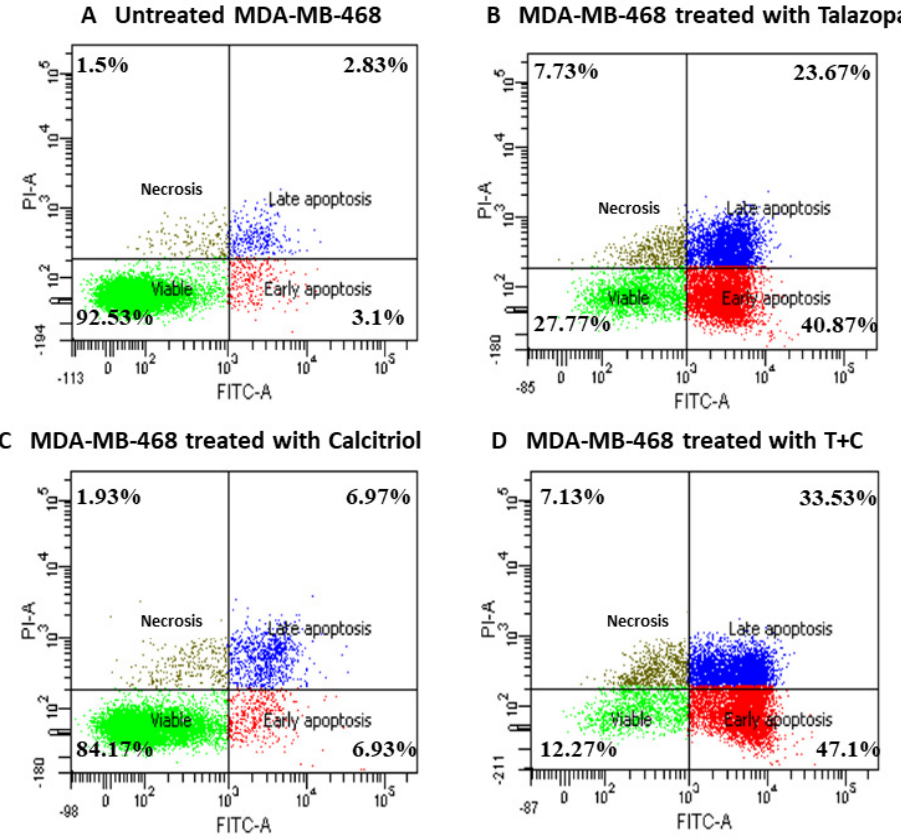
Figure 9. Annexin V/FITC − PI flow cytometry analysis of MDA − MB − 468. Cells (1 × 10 6 cells/mL)